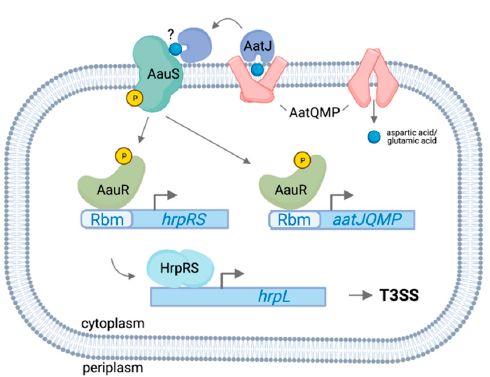
Figure 2. Model of regulation of the T3SS in P. syringae by AauSR. Depicted is a P. syringae cell, with only the inner membrane (separating the periplasm and cytoplasm) shown for clarity. In the periplasm, acidic amino acids such as aspartic and glutamic acid are bound by periplasmic solute binding protein AatJ (mauve). AatJ assists transport of these amino acids into the cytoplasm through interaction with the AatQMP ABC transporter (pink), and may additionally interact with the inner membrane histidine kinase AauS (teal). AauS activates its cognate response regulator AauR (olive) through phosphorelay. In its active conformation, AauR stimulates expression of the aatJQMP operon through binding of a conserved AauR binding motif (Rbm) in the aatJ promoter. AauR additionally induces hrpRS expression through binding an Rbm in the hrpRS promoter.